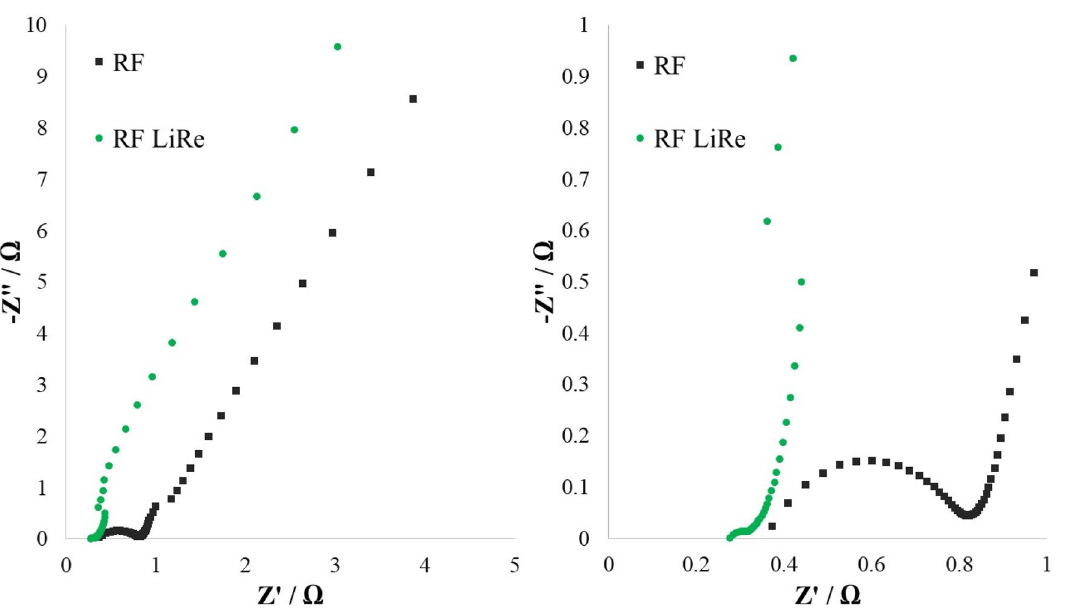
Fig. 7 Electrochemical impedance spectroscopy curves obtained for gels prepared with sodium carbonate (RF) and lithium perrhenate (RF LiRe) catalysts